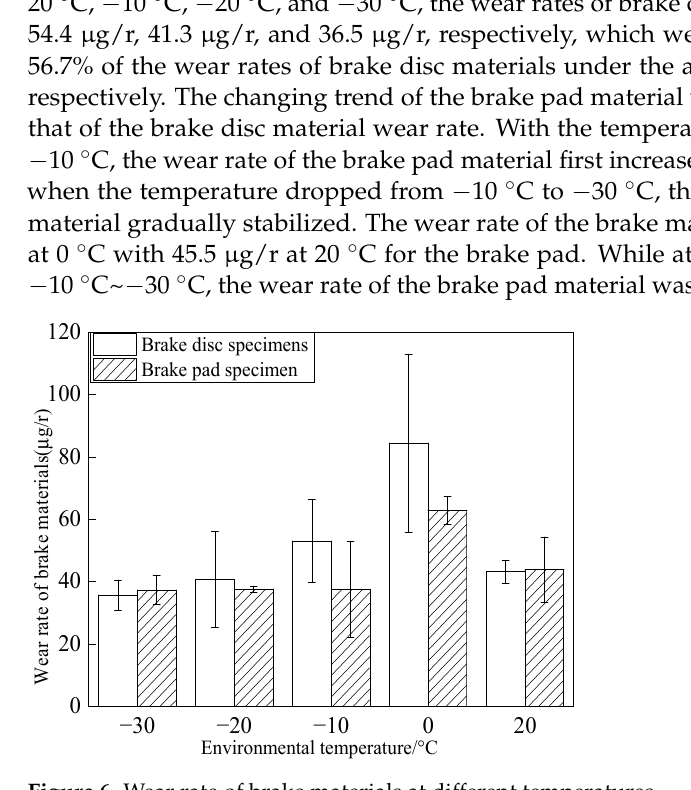
Figure 6. Wear rate of brake materials at different temperatures.